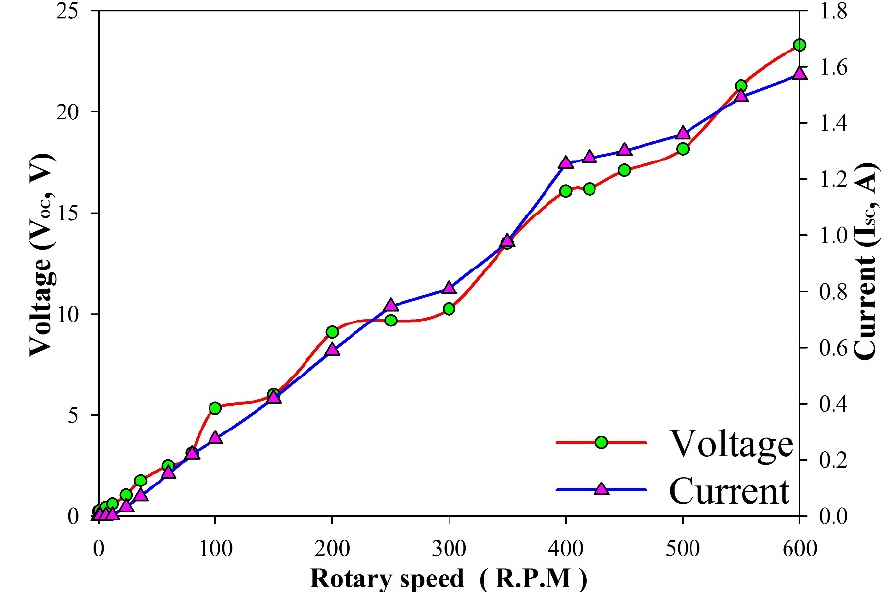
Figure 6. The open-circuit voltage and the short-circuit current of the disk generator under various rotational